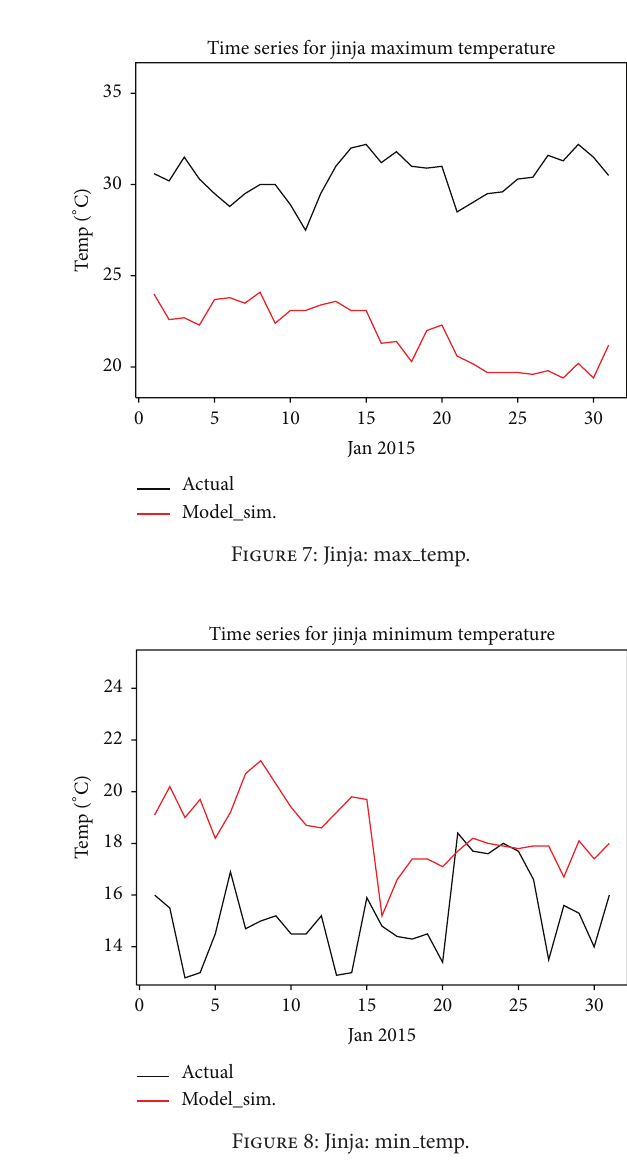
Figure 6: Kasese: min temp.